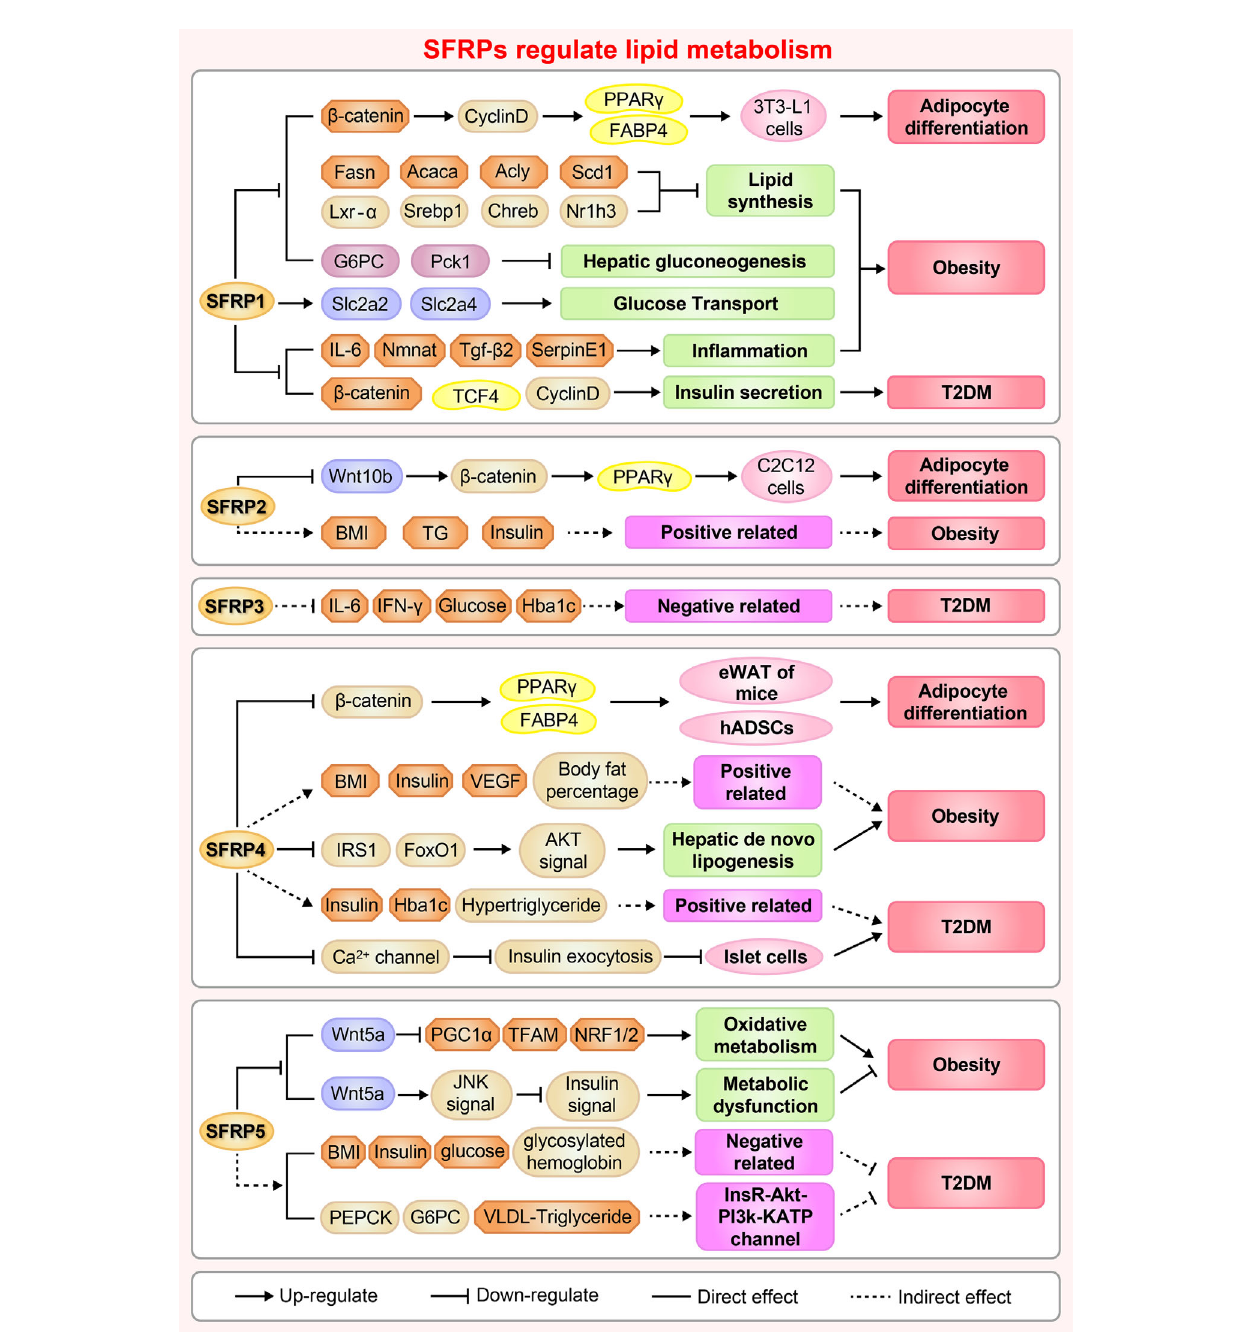
FIGURE 3 | A brief overview of the molecular mechanisms by which SFRPs regulate lipid metabolism and cardiovascular disease. The fi gure shows the potential mechanisms by which how SFRPs modulate adipocyte differentiation, obesity and type 2 diabetes mellitus (T2DM). Acaca, acetyl-Coenzyme A carboxylase alpha; Acly, ATP citrate lyase; Akt, AKT serine/threonine kinase 1; Rho, rhodopsin; BMI, body mass index; Chreb, cAMP responsive element binding protein; FABP4, fatty acid binding protein 4; Fasn, fatty acid synthase; Foxo1, forkhead box O1; G6PC, glucose-6-phosphatase, catalytic; hADSCs, adipose mesenchymal stem cells; Hba1c, Glycosylated hemoglobin; IFN- g , interferon- g ; IL-6, leukotriene-6; IRS1, insulin receptor substrate 1; Lxr- a , LexA regulated function- a ; Nmnat, Nicotinamide mononucleotide adenylyltransferase; Nr1h3, nuclear receptor subfamily 1 group H member 3; NRF1/2, nuclear respiratory factor 1/2; Pck1, phosphoenolpyruvate carboxykinase 1, cytosolic; PCP, Pupal cuticle protein; PEPCK, phosphoenolpyruvate carboxykinase; PPAR g , peroxisome proliferator activated receptor- g ; BNP, natriuretic peptides A-like; Scd1, stearoyl-Coenzyme A desaturase 1; SerpinE1, serpin family E member 1; SFRP1, secreted frizzled related protein1; Slc2a2/4, solute carrier family 2 (facilitated glucose transporter), member 2/member4; Srebp1, sterol regulatory element binding protein 1; TCF4, transcription factor 4; TFAM, transcription factor A, mitochondrial; TG, triglyceride; Tgf- b 2, transforming growth factor b 2; VEGF, vascular endothelial growth factor.